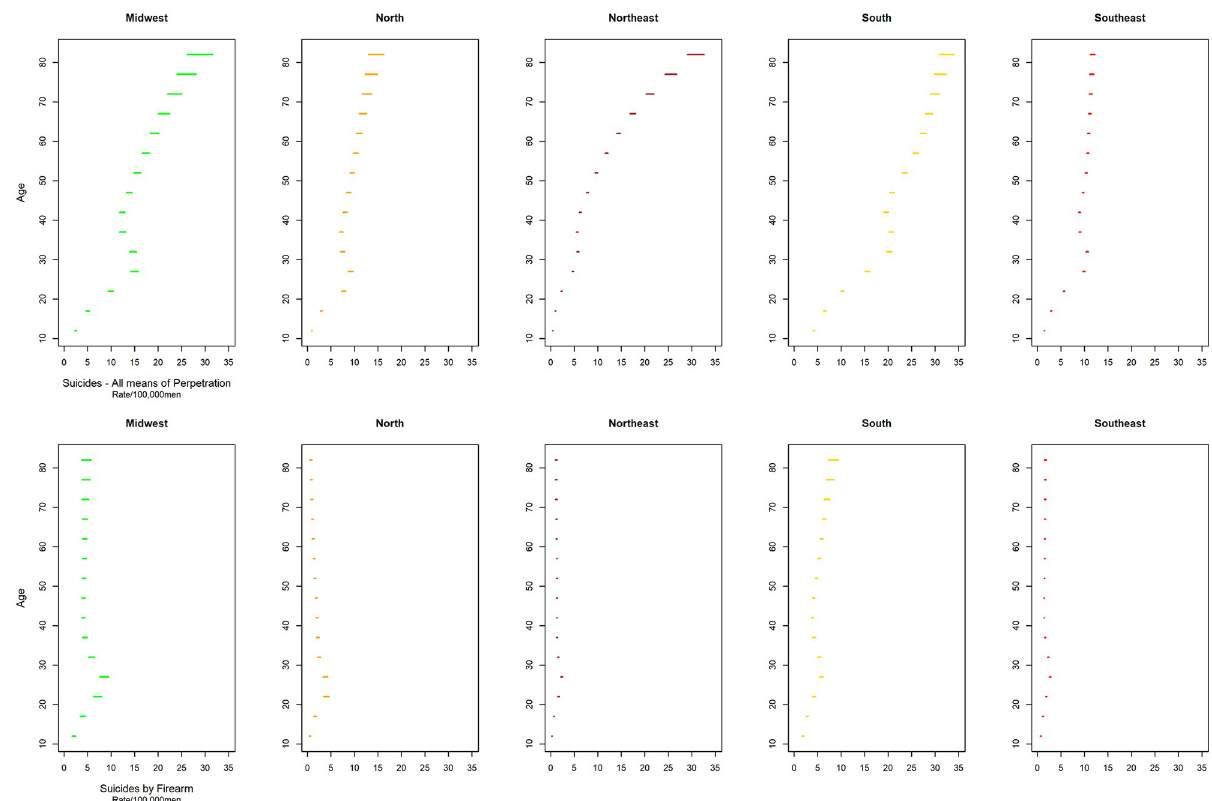
Fig 6. Mortality rates by age group, per 100,000 men, adjusted for period and cohort effect, for total suicide by firearms, from 1980 to 2019, Brazil and its major regions.